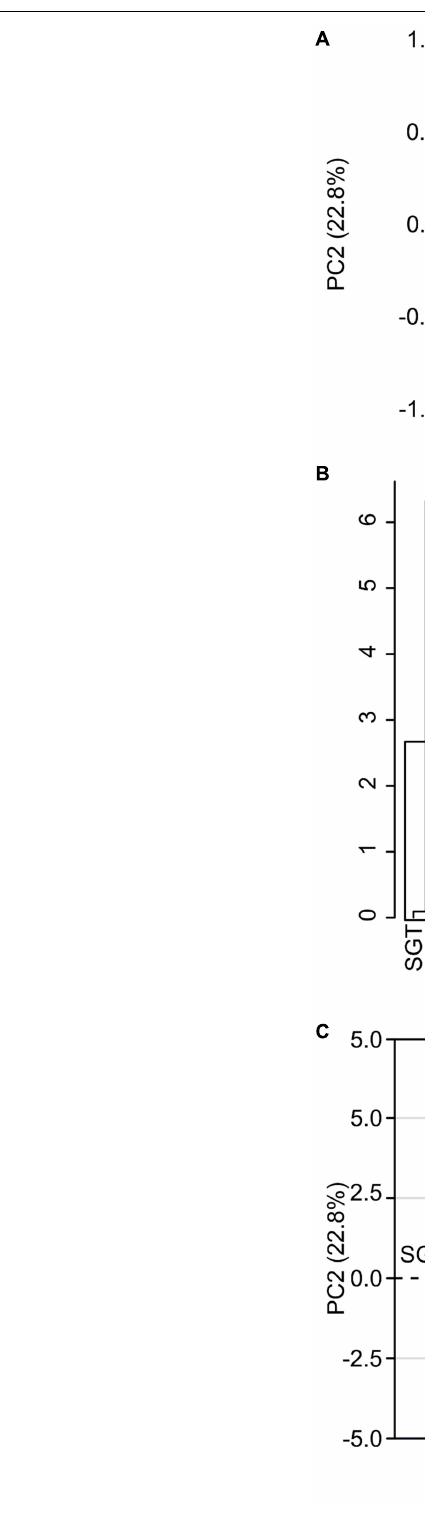
Frontiers in Microbiology |